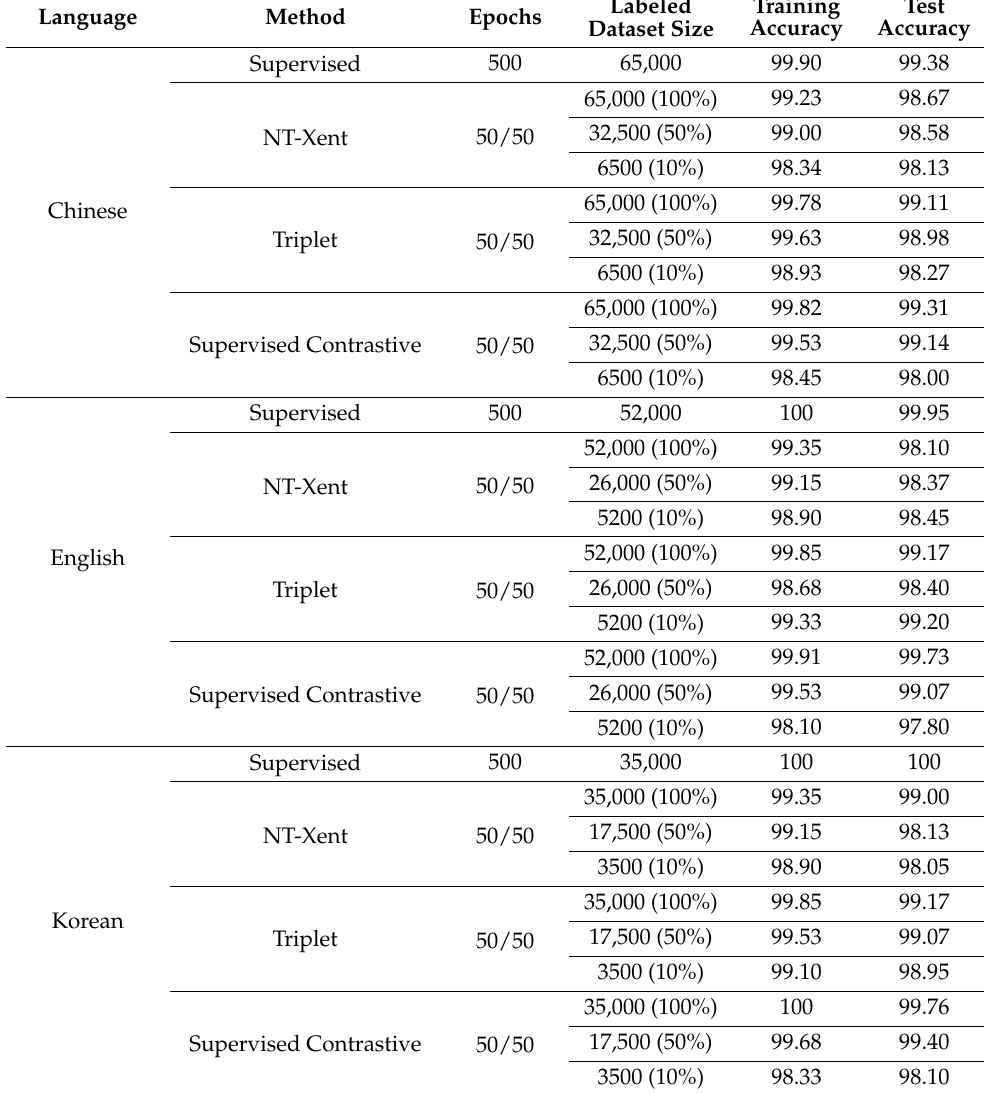
Table 1. Comparison of training and test accuracies of classifiers trained on NT-Xent, triplet, and supervised contrastive approaches with a fully supervised classifier used as a